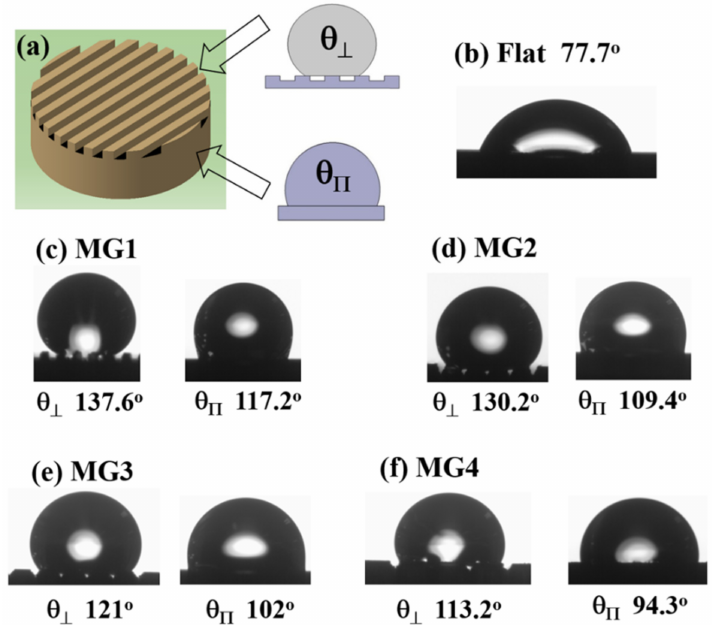
Figure 3. ( a ) Directions of water contact angle measurement on MG: perpendicular ( θ ⊥ ) and parallel ( θ Π ) to the direction of MG. Images of water droplets on surfaces, prior to their long-term exposure to 3.5 wt. % NaCl solution: ( b ) flat surface and ( c – f )